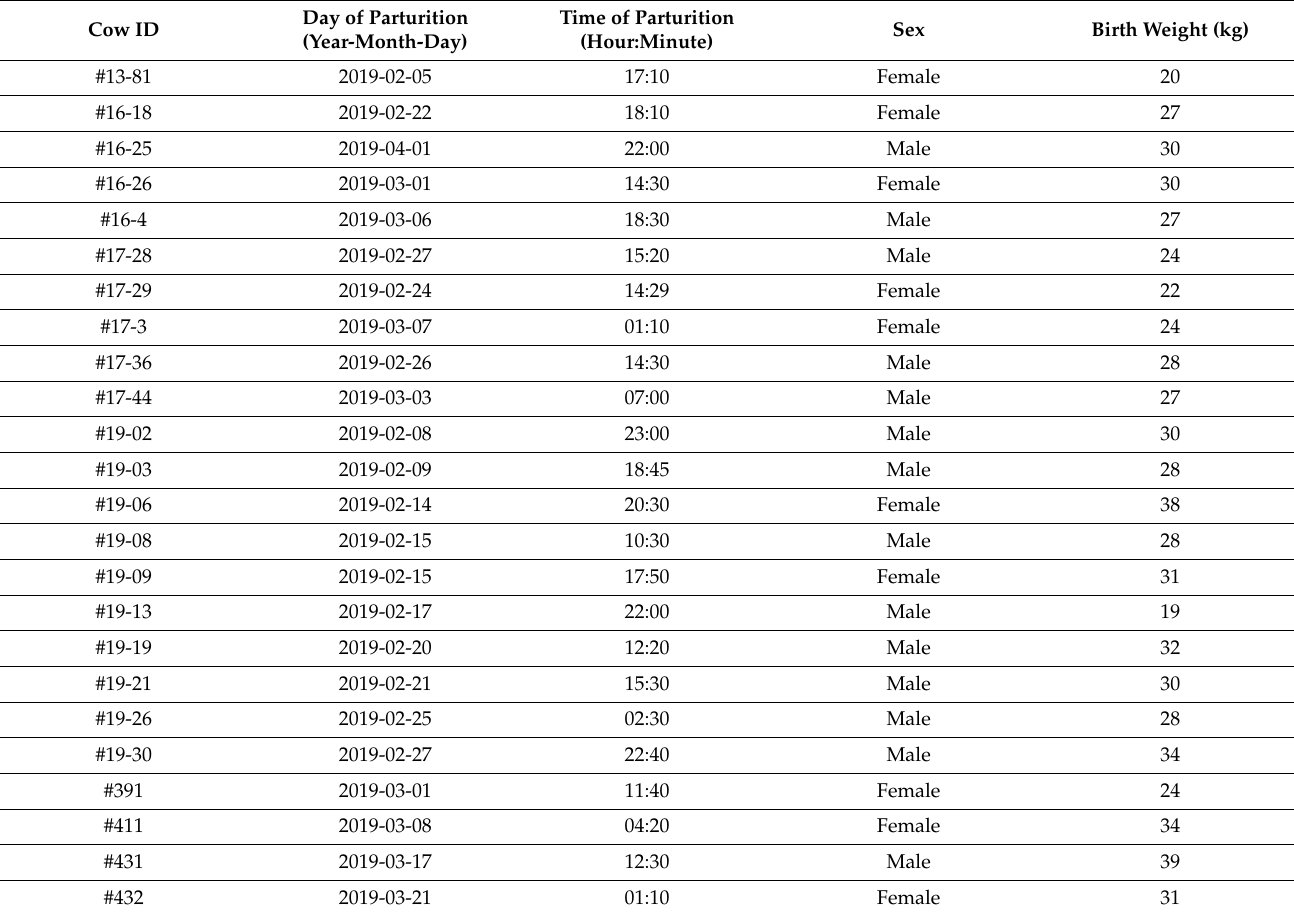
Table 1. Information of parturition and offspring in experiment group ( n =